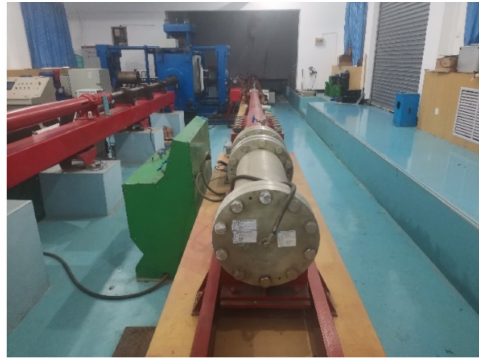
Figure 2. 100 mm diameter SHPB test device.